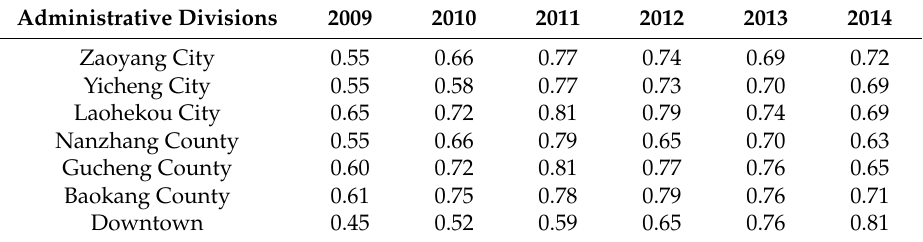
Table 4. Calculation results of SEDI from 2009 to 2014 in Xiangyang